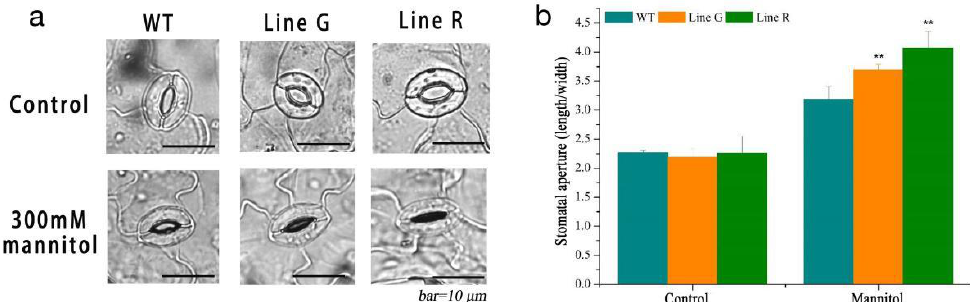
Figure 5. Stomatal movement of MfPIF8 OE lines and WT in responding to 300 mM mannitol treatment. ( a ) Microscopy observation of stomata opening and closing degrees. ( b ) Changes in the stomatal aperture (ratio of stomata length/width). At least 60 stomata from 6 plants of each line were measured and three biological repeats were performed. Data are presented as mean and SD values of three independent experiments. Asterisks indicate significant difference (** p < 0.01, by independent sample t -test) compared with WT.